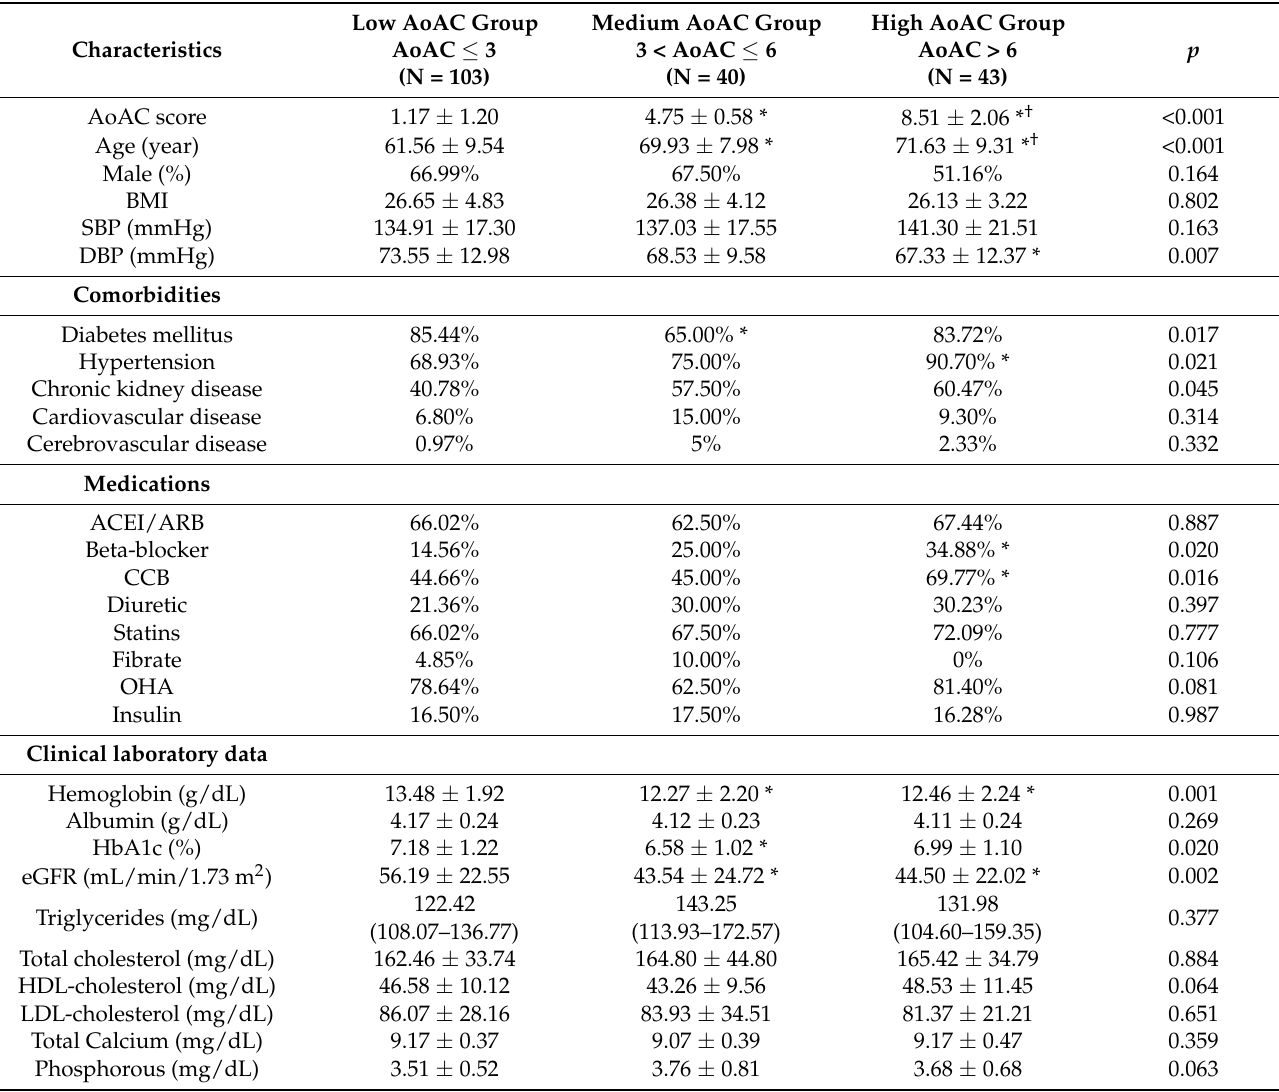
Table 1. Clinical characteristics of the study